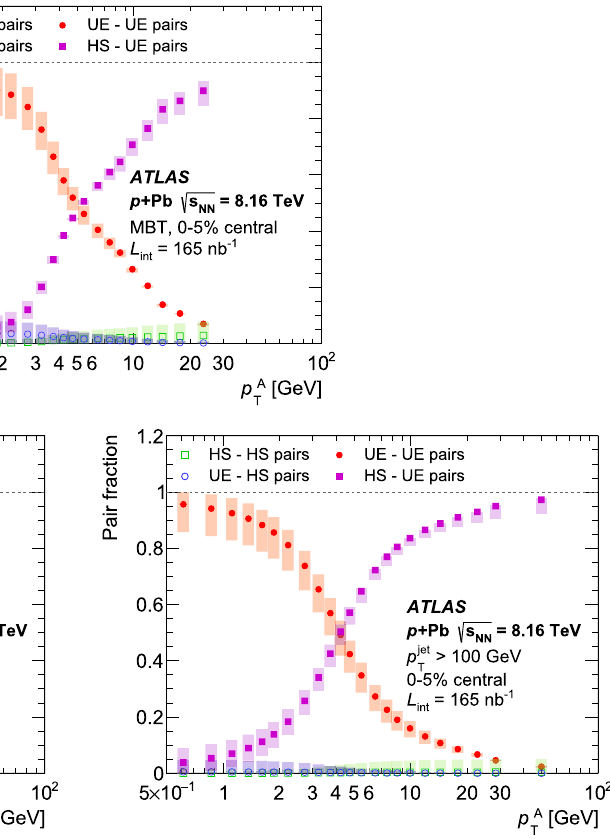
Fig. 10 ParticlepairyieldcompositionfractionsforMBTevents(top), events with jet p T > 75 GeV (bottom left), and events with jet p T > 100 GeV (bottom right) plotted as a function of the A-particle p T . GreenandblueopencirclesrepresentHS–HSandUE–HSpairs,respec-